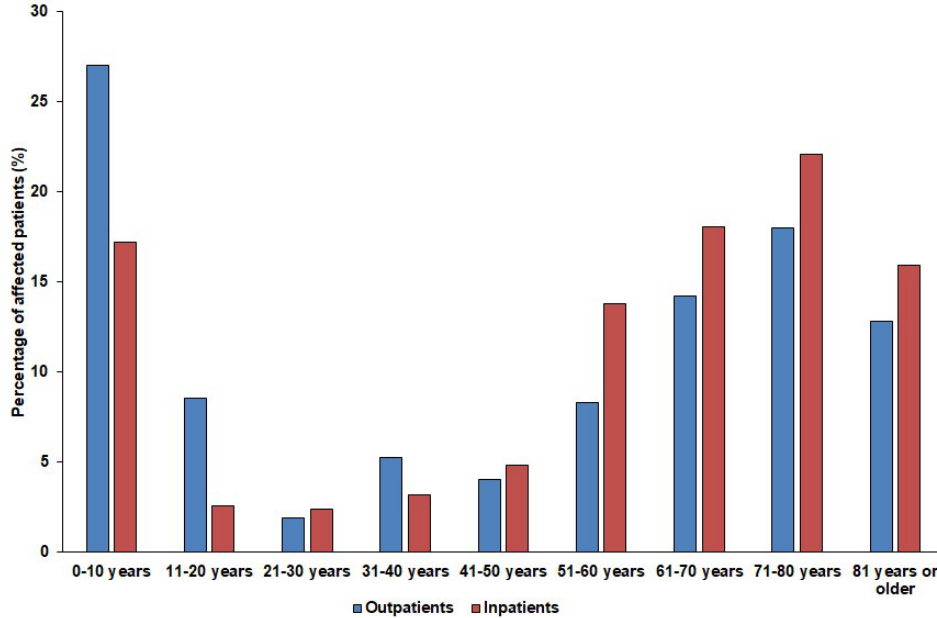
ff ected patients in the outpatient and inpatient Figure 1 . Age distribution of the affected patients in the outpatient and inpatient group. Figure 1. Age distribution of the a